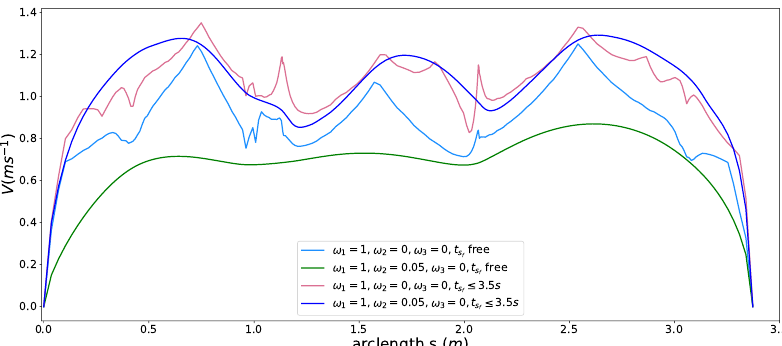
Figure 12. Speed profiles with semi-hard comfort box constraints.